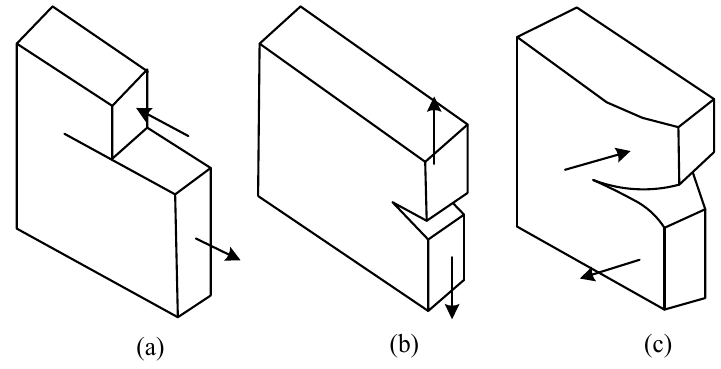
Figure 1. Crack fracture mode. (a)tensile (b)sliding (c)tearing